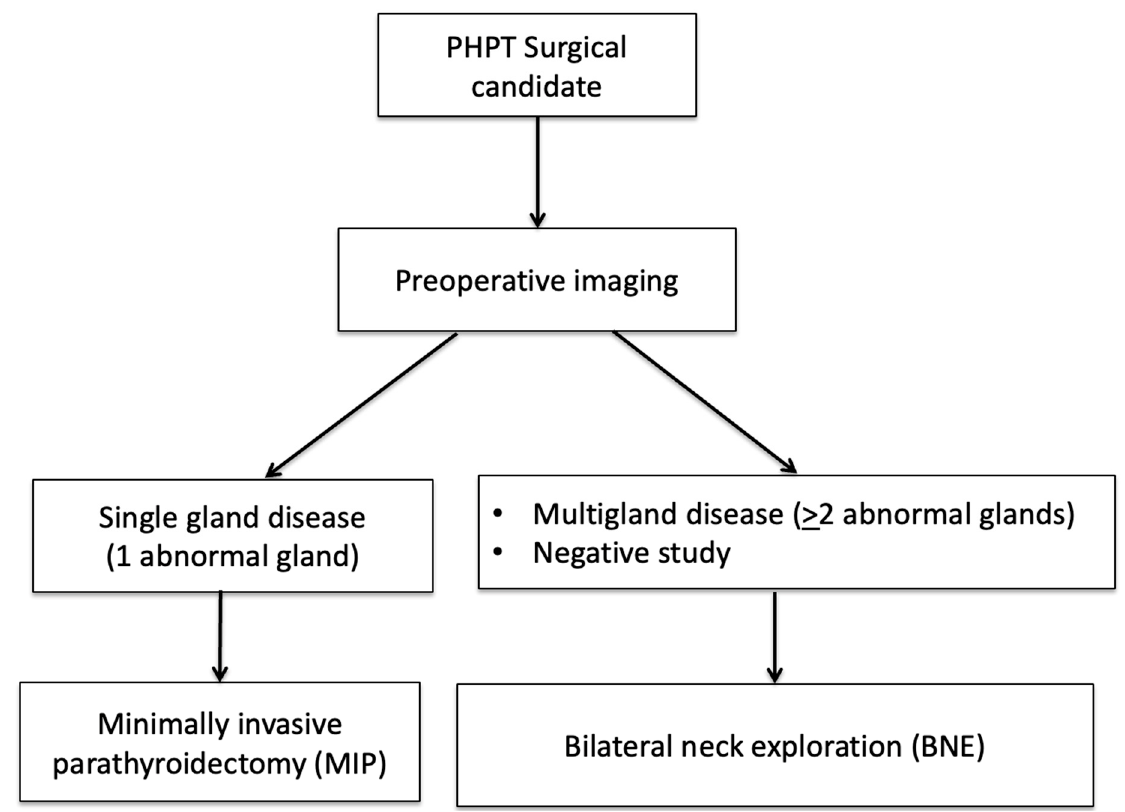
Figure 1. How imaging is used to guide parathyroid surgery.